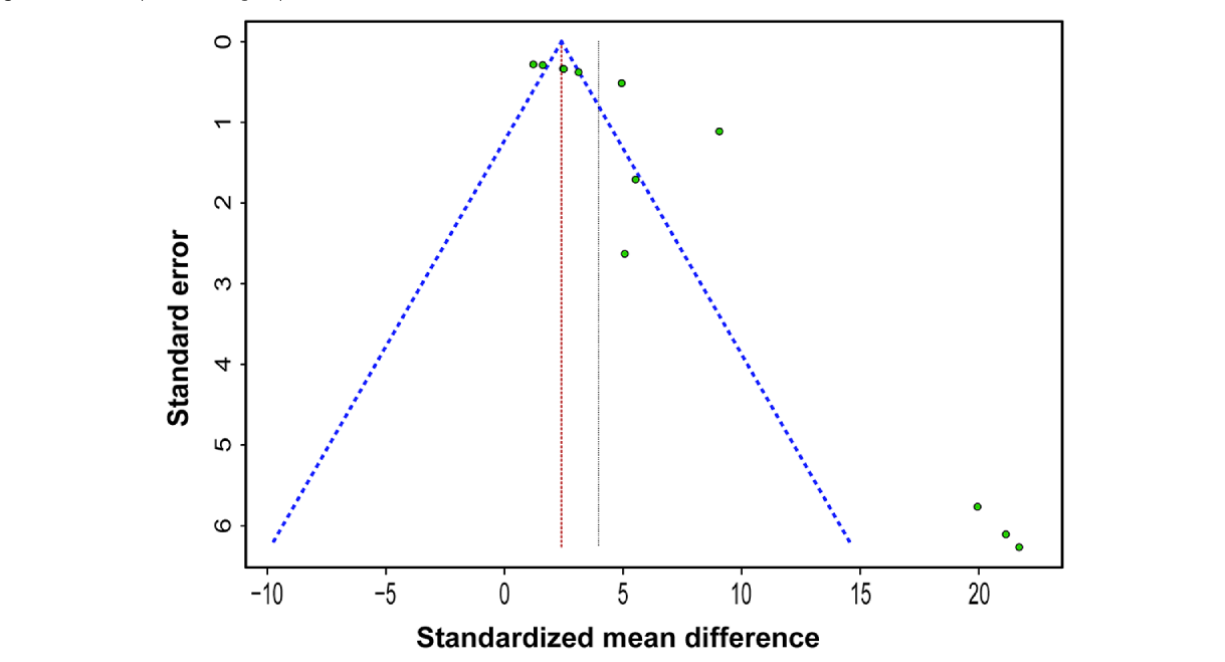
Figure 5. Funnel plot showing of publication bias